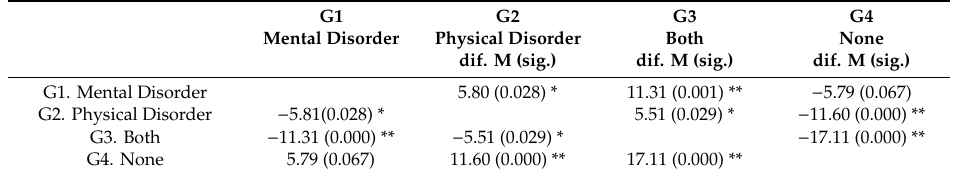
Table 4. Comparison of the impact of physical and mental disorders on the WHOQoL BREF scale: averages for each group: analysis of variance; mean di ff erences; statistical